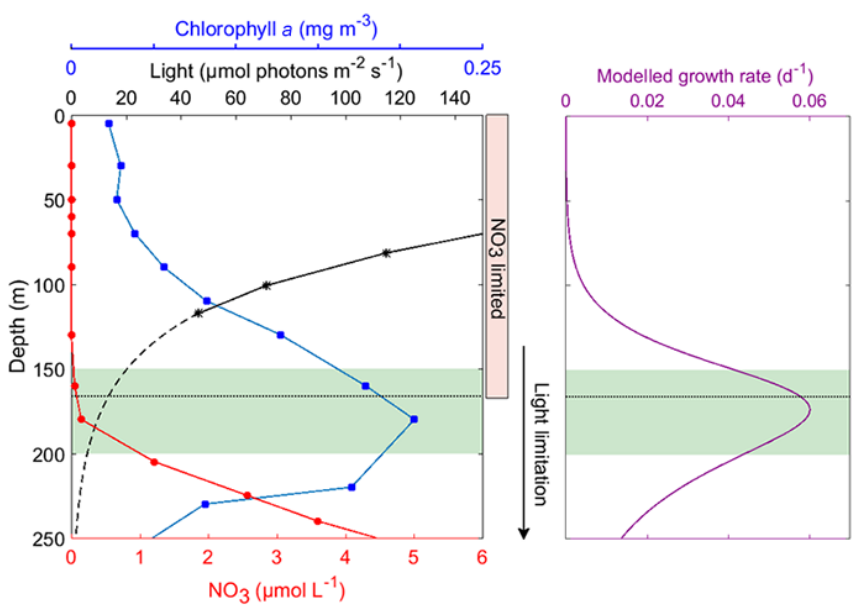
Figure 9. Left panel: In situ data (0 to 250m) at the GYR station of the BIOSOPE transect (114.01 ◦ W, 26.06 ◦ S). Profiles of in situ measured chlorophyll a , PAR irradiance and nitrate concentration are shown. The dashed line represents an extrapolation of the irradiance between 117m (last point measured) and 250m considering a constant attenuation coefficient K d ( K d = 0.025m − 1 from Claustre et al., 2008) and a simple light calculation taken from MacIntyre et al. (2002). The dotted black line is the depth at which the K N (0.09µM) is observed. This depth also corresponds to the lower limit of nitrate limitation. Light limitation starts above the DCM and intensifies with depth. The green shaded area corresponds to the location of the maximum of coccosphere abundance taken from Beaufort et al. (2008) between 120 ◦ and 107 ◦ W. The right panel shows the growth rate of E. huxleyi with depth at the GYR station (calculated using Appendix Eq.